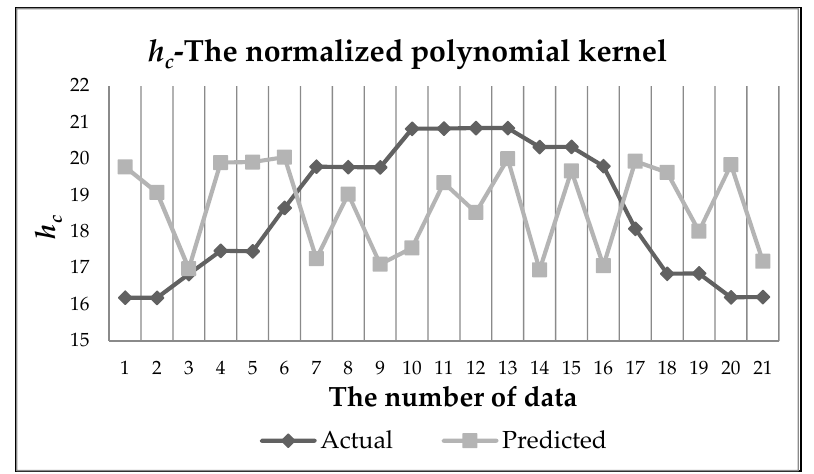
Figure 9. Actual and Predicted data of h c for normalized polynomial kernel.